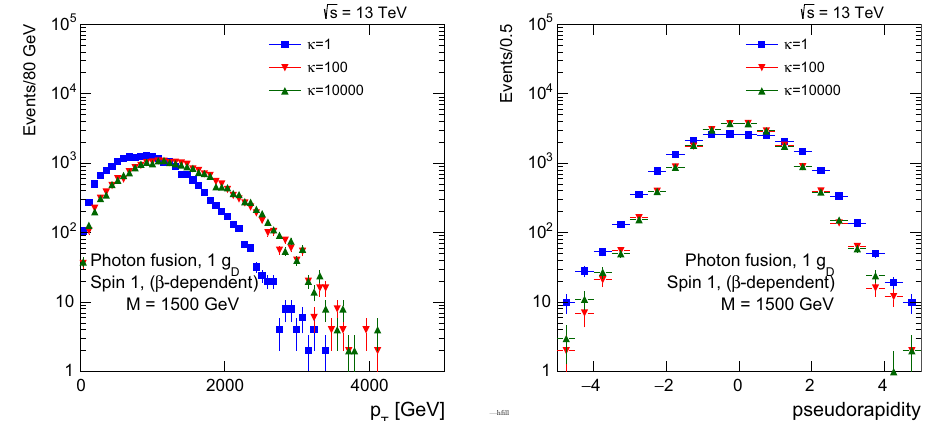
√ Fig. 27 Photon-fusion production at s = 13 TeV pp collisions for spin-1 monopole, β -dependent coupling and various values of the κ parameter: p T distribution for M = 1500 GeV (left); and η distribution for M = 1500 GeV